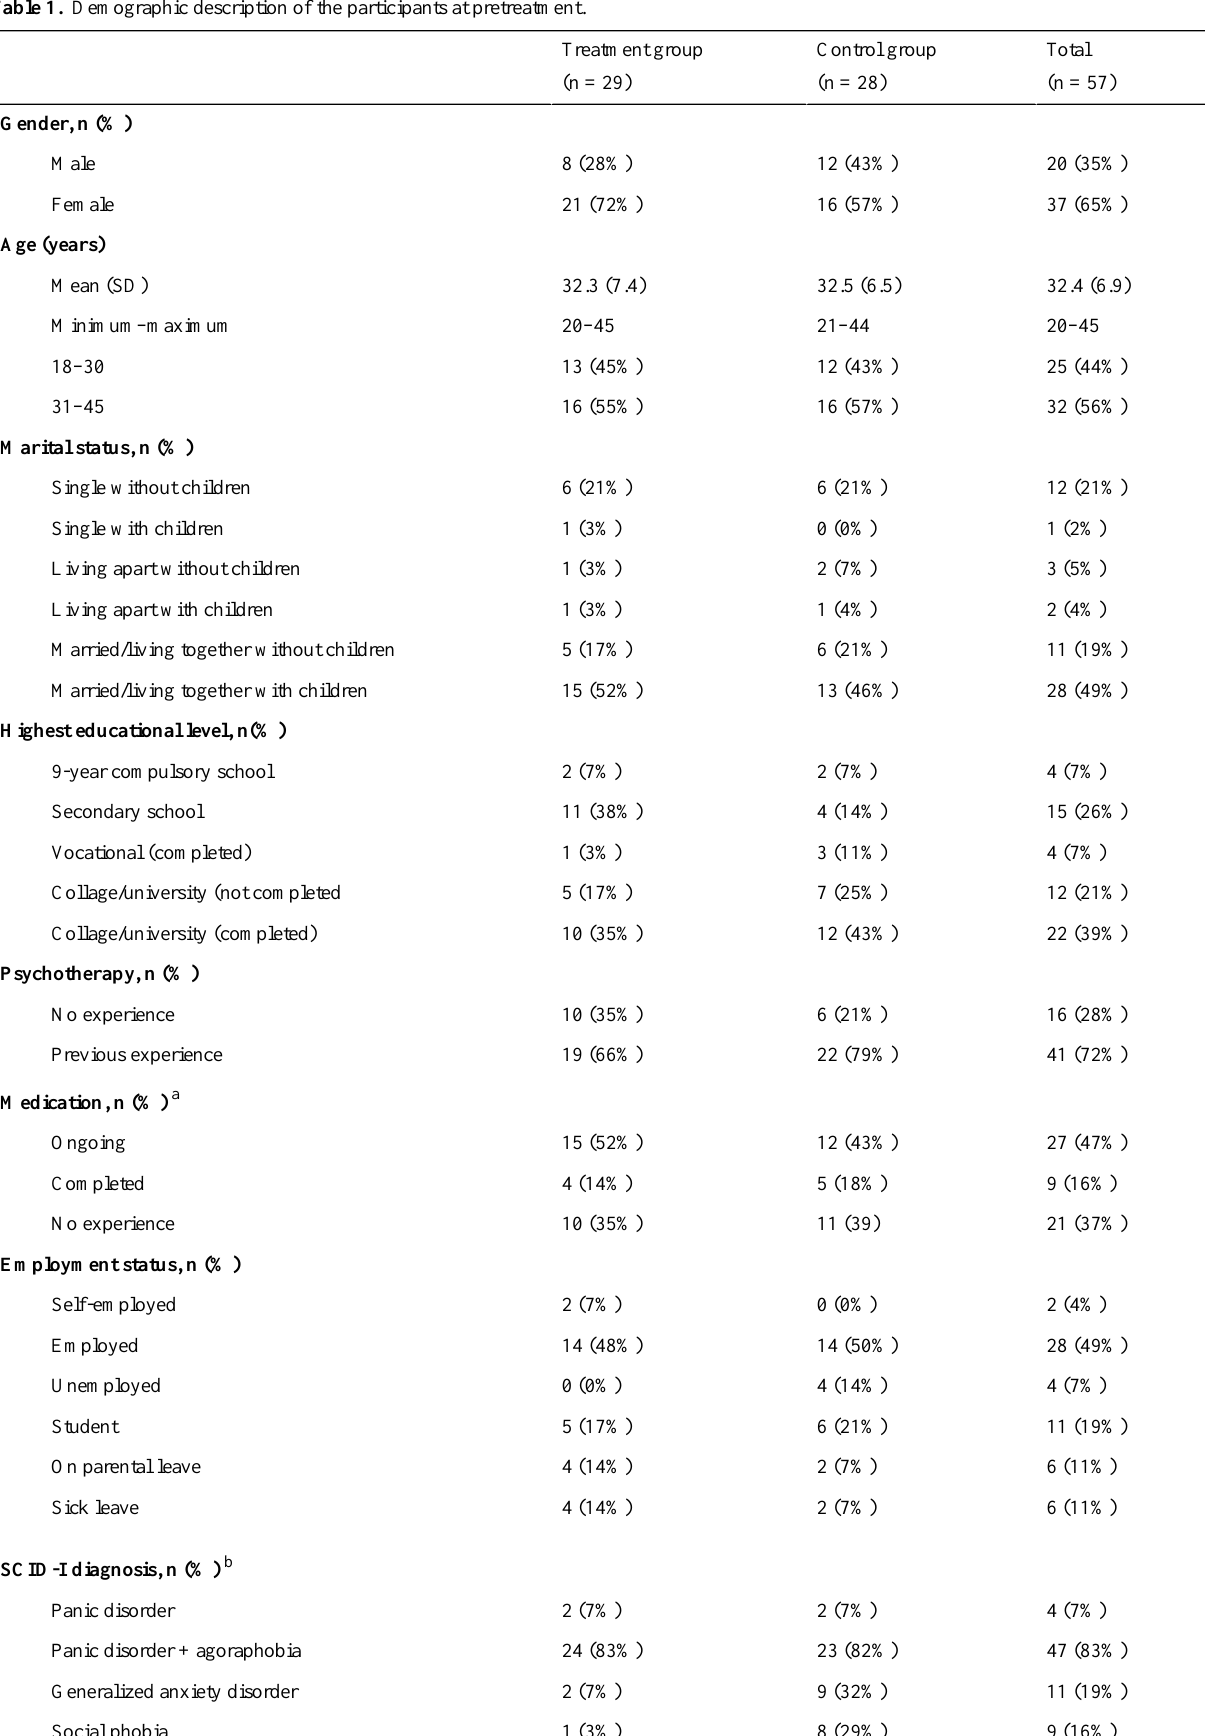
Table 1. Demographic description of the participants at